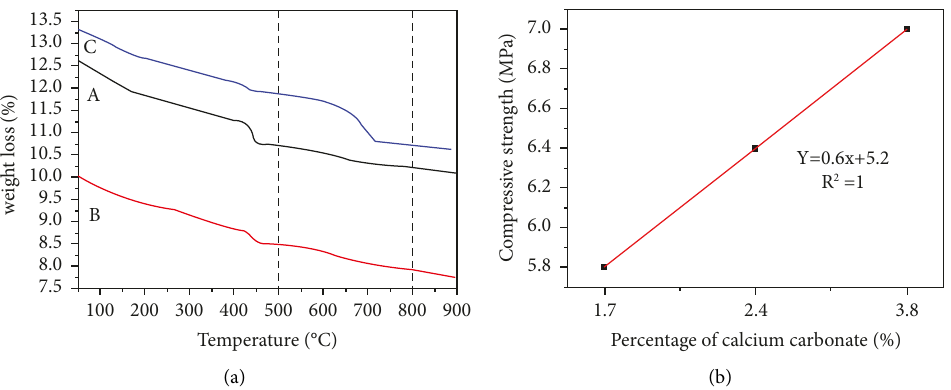
Figure 6: TG (a) and compressive strength (b) analysis of bentonite-amended cement formed in deionized water, bacterial suspension, and bacterial suspension with reaction solution. Table 1: Contrast of proportional strength increase in different